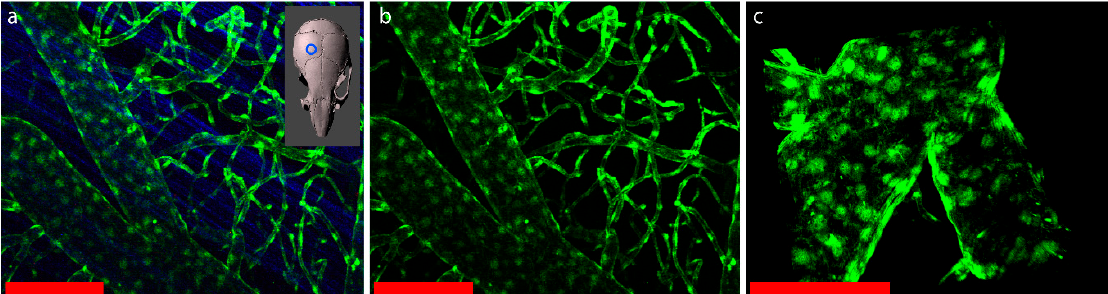
Figure 5. Representative images of the cranial and spinal cord window 2P-IVM imaging of the claudin-5-GFP reporter mouse. ( a ) The cranial window was placed over the right hemisphere of the mouse brain as depicted on the insert. Second harmonic generation in blue derives from collagen fibers in the dura mater. The strong GFP signal visible throughout the brain endothelial cells allows for imaging of the vessels along the entire vascular tree. ( b ) Cranial window region from (a) after removal of the dura mater. ( c ) Cervical spinal cord window. High magnification image showing the dorsal vein and branching veins. Scale bars = 100 µm.